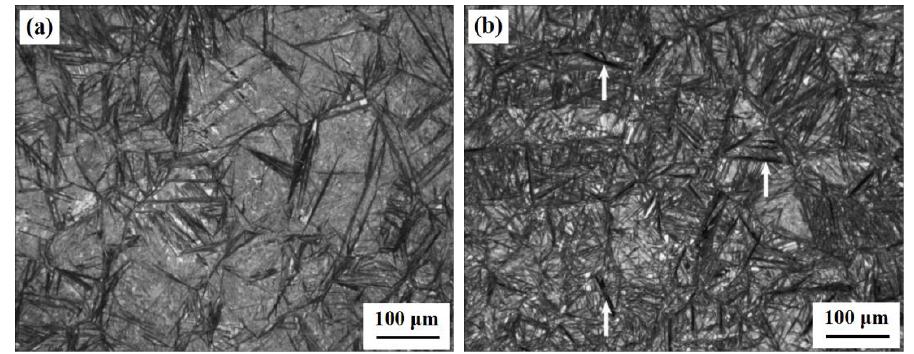
Figure 5. OM (optical microscopy) microstructures of ( a ), DIT and ( b ) QBT specimens after in situ observation.